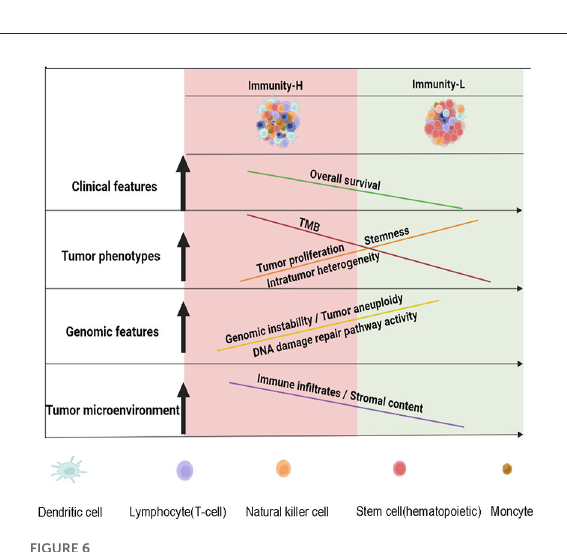
FIGURE6 A schematic illustration to summarize the molecular and clinical features of both immune subtypes of HPV + cervical cancer. HPV + cervical cancer can be classified into two subtypes with high and low immunity, respectively. The low immunity is associated with tumor progressive phenotypes, unfavorable prognosis, and genomic instability in HPV + cervical cancer. The figure was created with